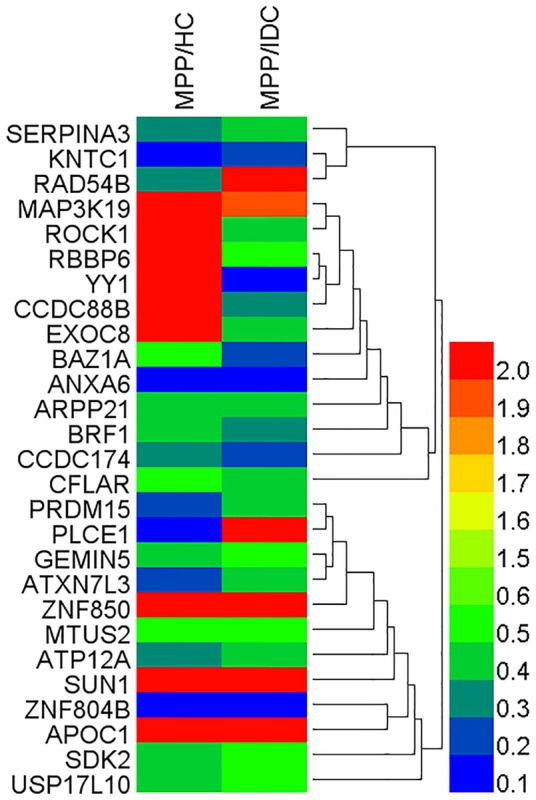
Heat map of the 27 identified proteins. The most striking area of up-regulation in TB patients is seen in the region where a series of protein peaks showed in red.